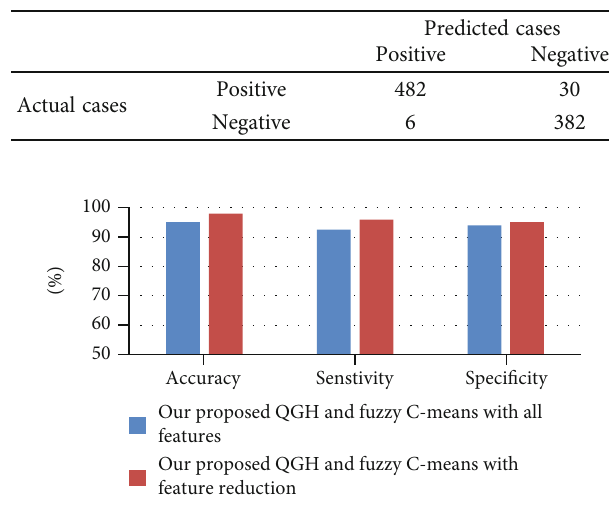
Figure 5: Accuracy results for proper feature space reduction.